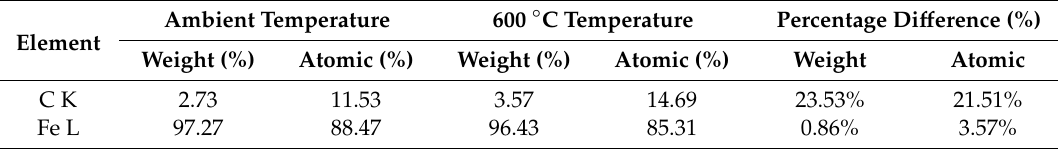
Table 2. The chemical composition of CFS on ambient and 600 ◦ C temperature.